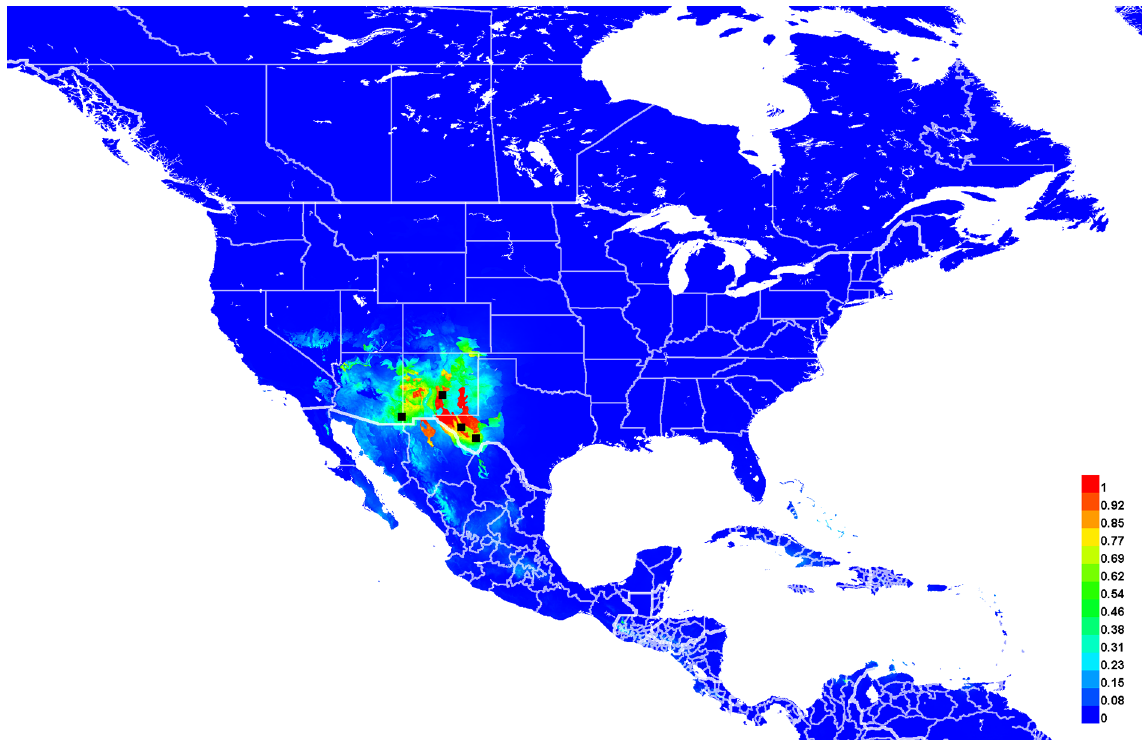
Fig. 27. Georeferenced collection records of Lasioglossum ( D. ) clavicorne sp. nov. (black squares) and predicted distribution by maximum entropy ecological niche modeling in Maxent (colour